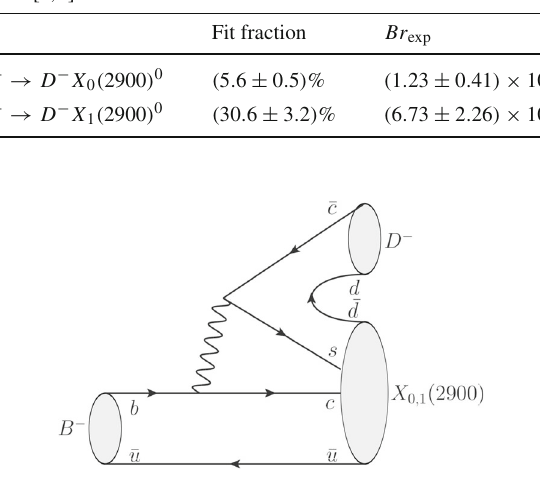
¯ d generated from